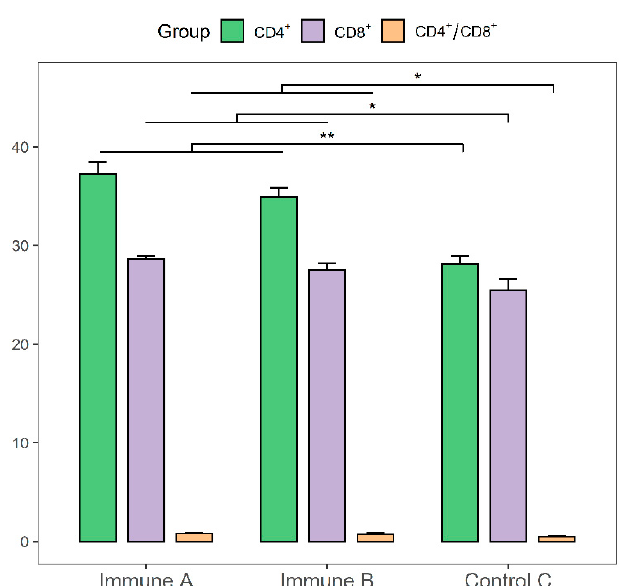
Figure 9. T lymphocytes were analyzed in the spleens of piglets from different immunization groups. The CD4 + and CD8 + levels were evaluated on day 35. * p < 0.05 presents a significant difference, and ** p < 0.01 shows a highly significant difference.